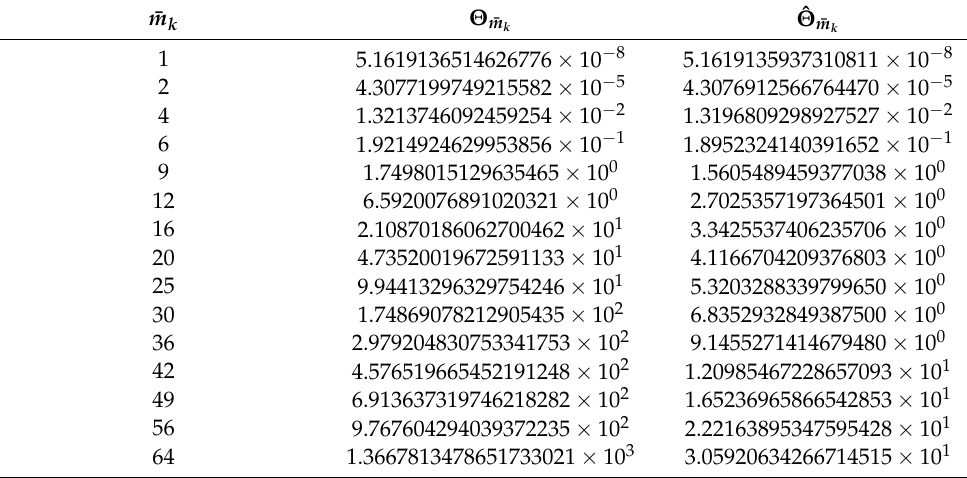
Table 2. Values of Θ ¯ m Series (12).